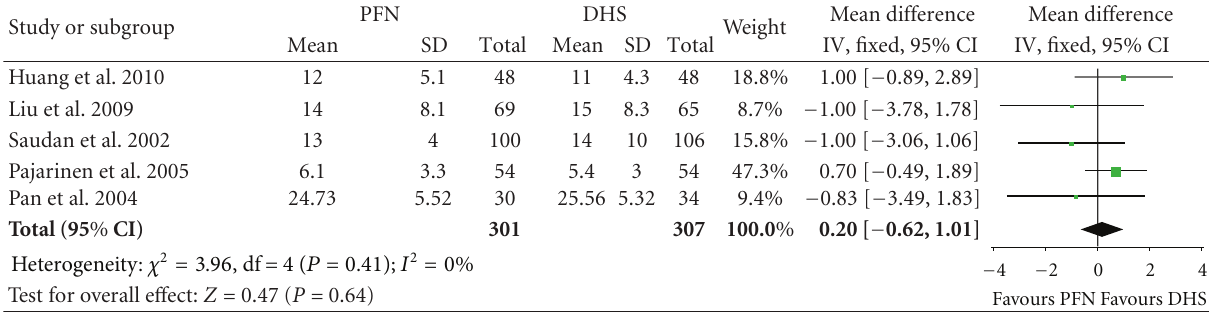
Figure 5: Comparison of hospital stay between PFN and